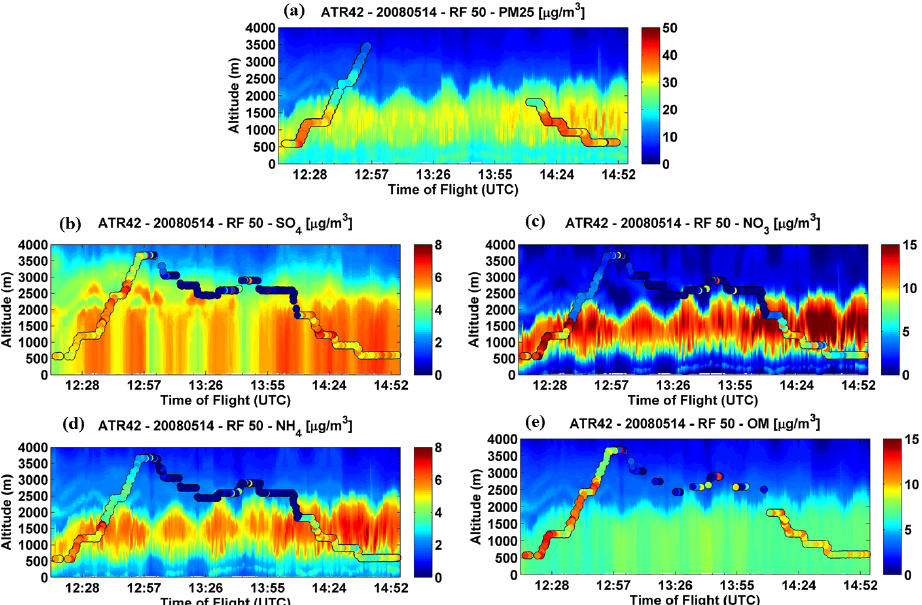
Figure 8. Vertical profiles (shadow) along the flight track of 14 May (RF50) of modelled PM 2 . 5 (a) , SO 4 (b) , NO 3 (c) , NH 4 (d) , and OM (e) . The circles are the measurements collected aboard the ATR42.